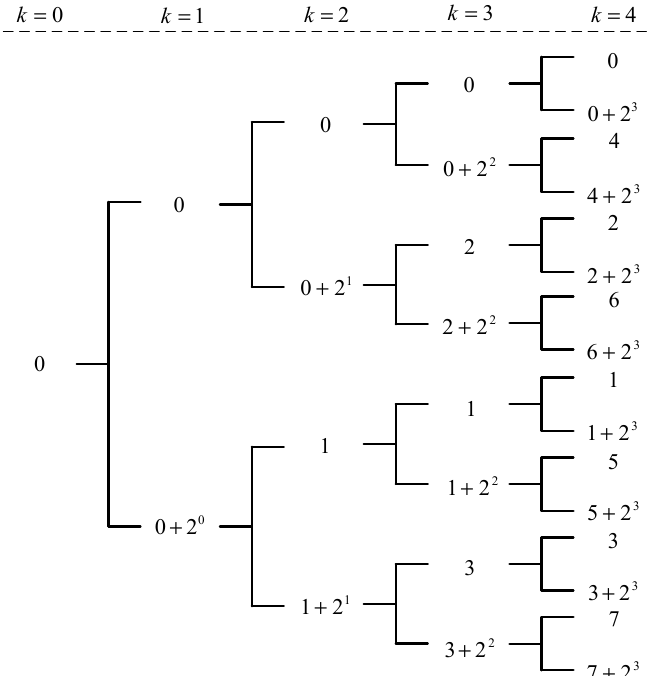
( k ) Figure 1. Values of c in dynamic overlapping batch means estimator (DOBM) with the recursive Figure 1. Values of 𝑐 (cid:3037)((cid:3038)) in dynamic overlapping batch means estimator (DOBM) with the recursive j relation.